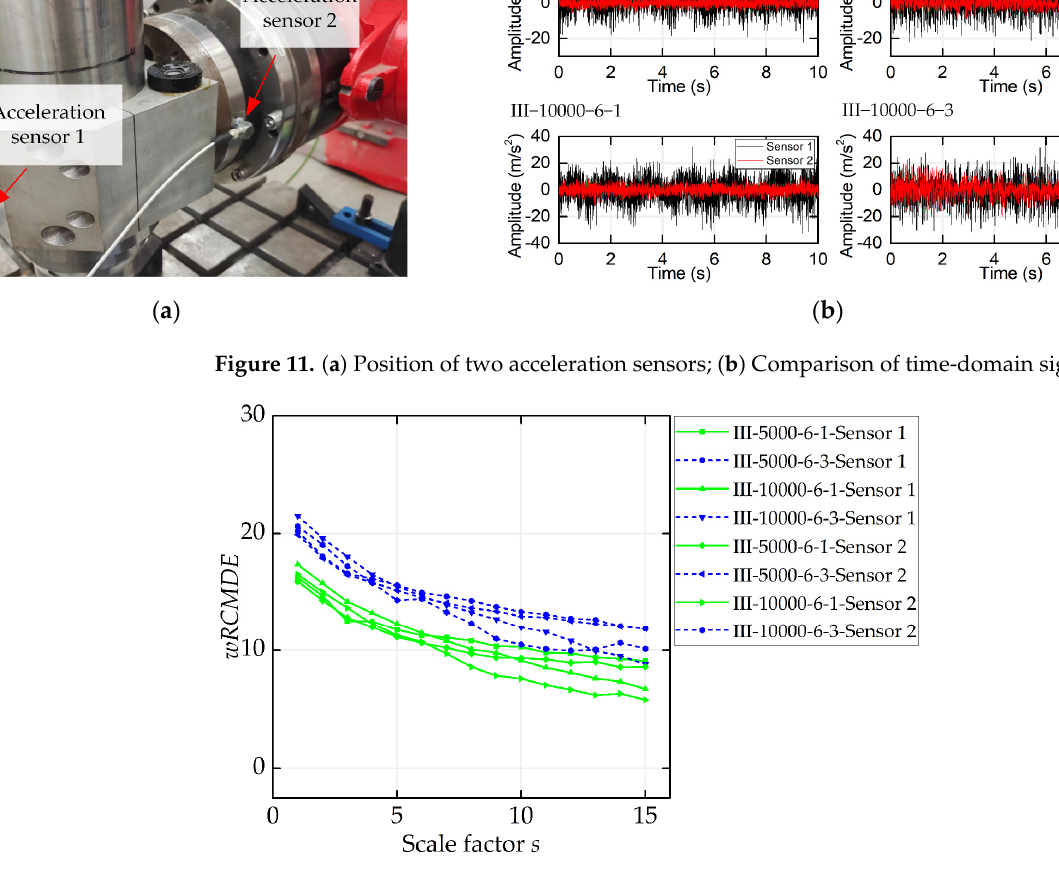
Figure 12. wRCMDE with different scale factors. Green lines indicate a chatter-free state, and blue dashed lines indicate a chatter state.